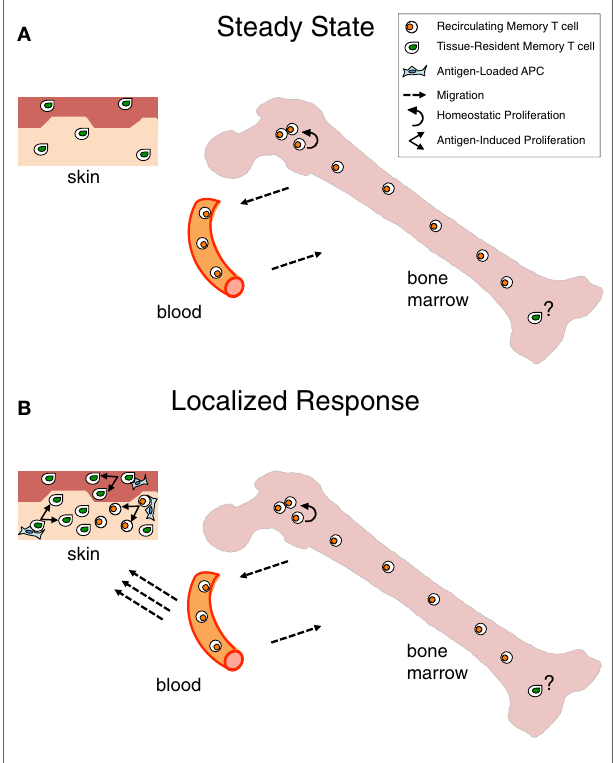
FiGURe 1 | Contribution of bone marrow memory T cells and tissue-resident memory T cells to long-lasting immunity . (A) Under steady state, Bone Marrow (BM) memory T cells are in constant exchange with the recirculating memory T cell pool, while tissue resident memory T (TRM) cells are fixed within peripheral organs, e.g., skin, in a quiescent state. Although the majority of BM memory T cells are quiescent, a minor proportion of them self-renew within BM niches, mostly in response to cytokines, e.g., IL-15. This homeostatic proliferation counterbalances losses due to cell death and contributes to maintain constant numbers of recirculating memory T cells over time (8, 9). The putative possibility that a few TRM cells exist in the BM is depicted. (B) When infection is localized in peripheral organs, TRM cells represent a first line of defense that is reinforced by the arrival of recirculating memory T cells, acting as a second line of protection. Antigen presented by APC in the peripheral tissue leads